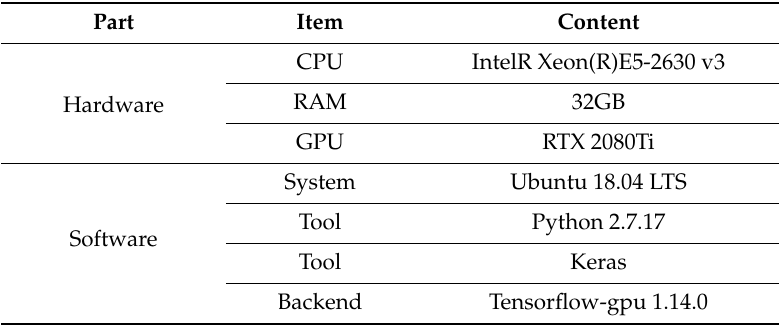
Table 2. Hardware and software specifications.